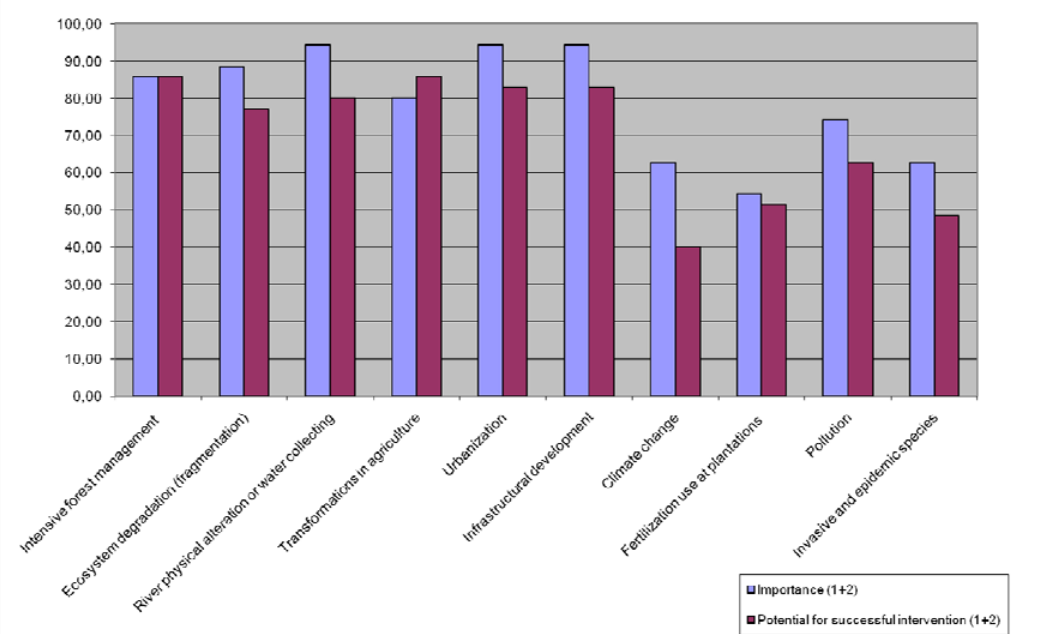
Fig. A2.2: Importance and potential for successful intervention of the different direct drivers analyzed in the questionnaire completed by participants before the workshops. The importance is measured as the percentage of respondent that value each indirect driver of high importance (=1) or important (=2); whereas potential for successful intervention is measured as the percentage of respondent that reported a high (=1) or medium (=2) potential for successful intervention from Biscay for each of the studied indirect